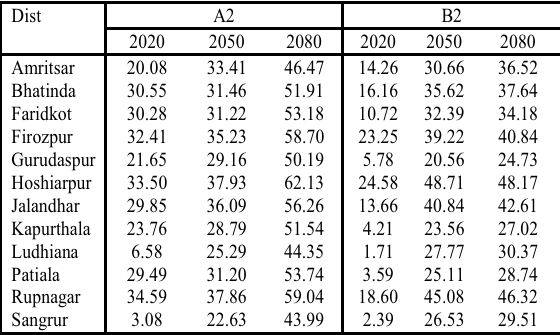
Table 1. District-wise reduction in cropping system yield under different climate change